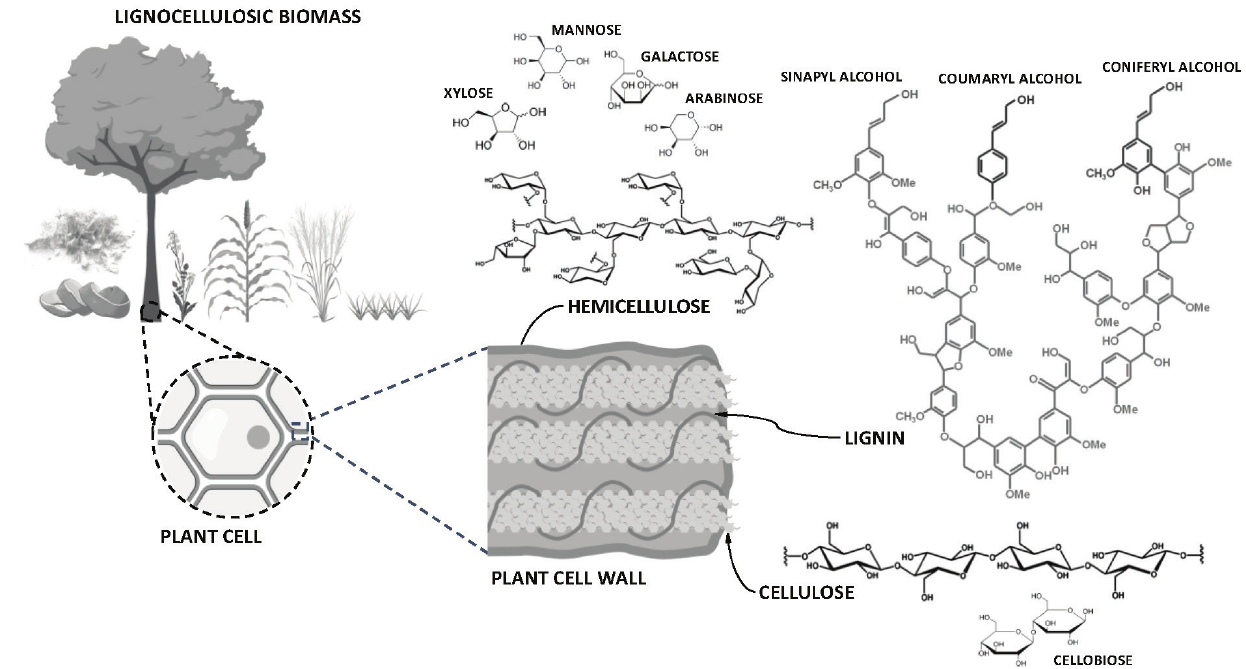
Fig. 1 – Schematic representation of lignin, cellulose, and hemicellulose as the main components of lignocellulosic